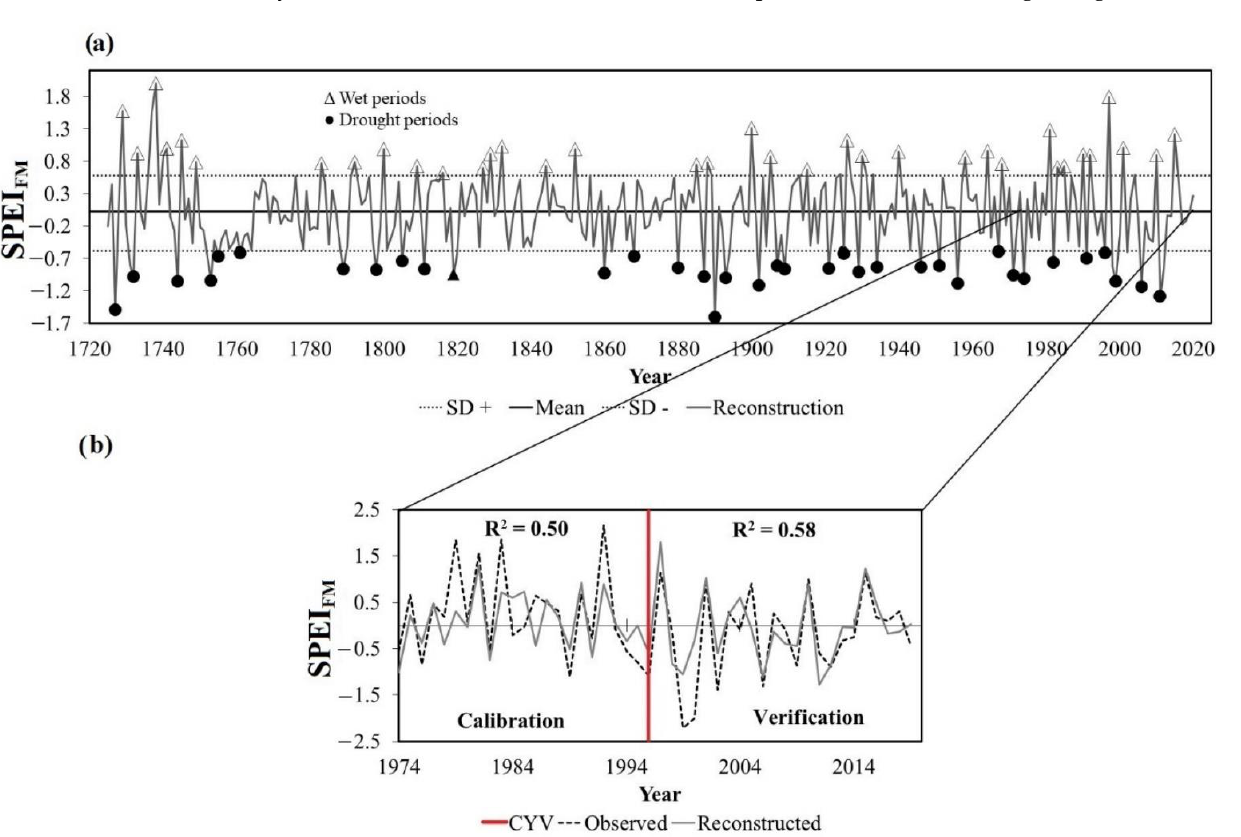
Figure 6. ( a ) Reconstructed SPEI for the western region of the State of Durango during 1725 – 2020; ( b ) comparison between observed SPEI (dashed line) and reconstructed SPEI (gray line). Triangles denote wet years and black dots represent extreme drought events. The vertical red line indicates the year in which the instrumental SPEI was split for calibration and verification purposes.